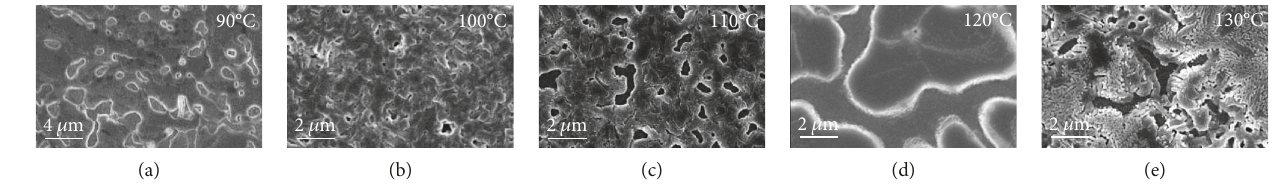
fi lms deposited on the c-TiO NH PbI Cl 3 3 3-X X